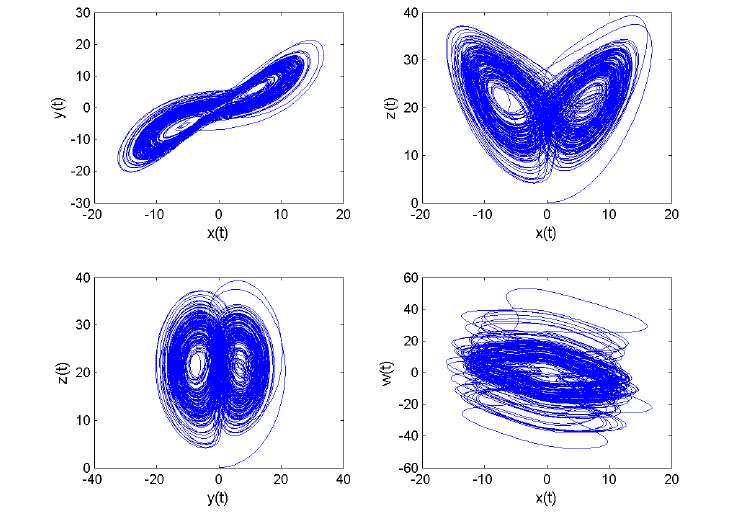
Figure 2. Hyperchaotic attractor of system ( 2 ) in 2 − D spaces with ( a , b , c , d , k , r ) = ) = ( 0.1,0.1,0.1,0.1 ) ( 12,23,1,2.1,6,0.2 ) and initial condition ( x 0 , y 0 , z 0 , w 0